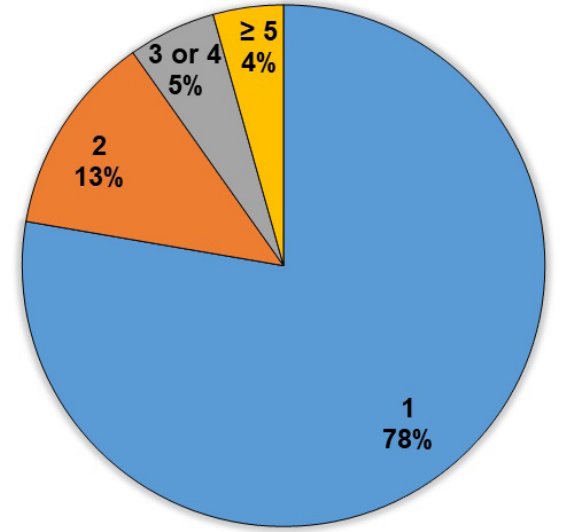
Figure 3. Distribution of ethnomedicinal plant species according to family. Figure 4. Number of ethnomedicinal plant species mentioned in selected Table 1. List of the most cited ethnomedicinal plant species in Ethiopian studies.